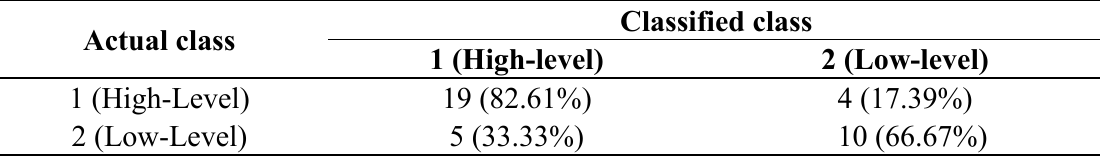
Table 9. RST-ANN model (model VI) results with only significant